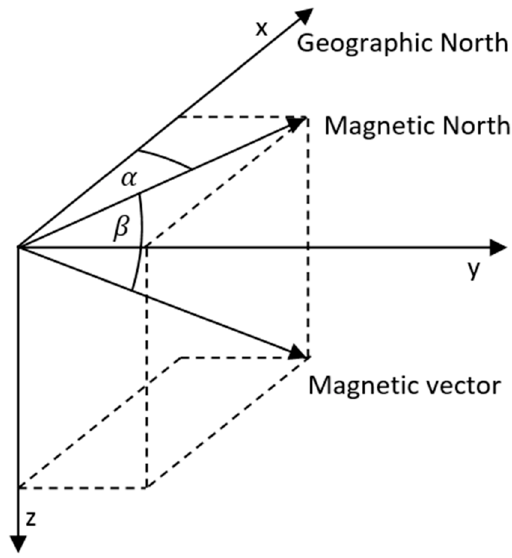
Figure 2. Magnetic field vector .